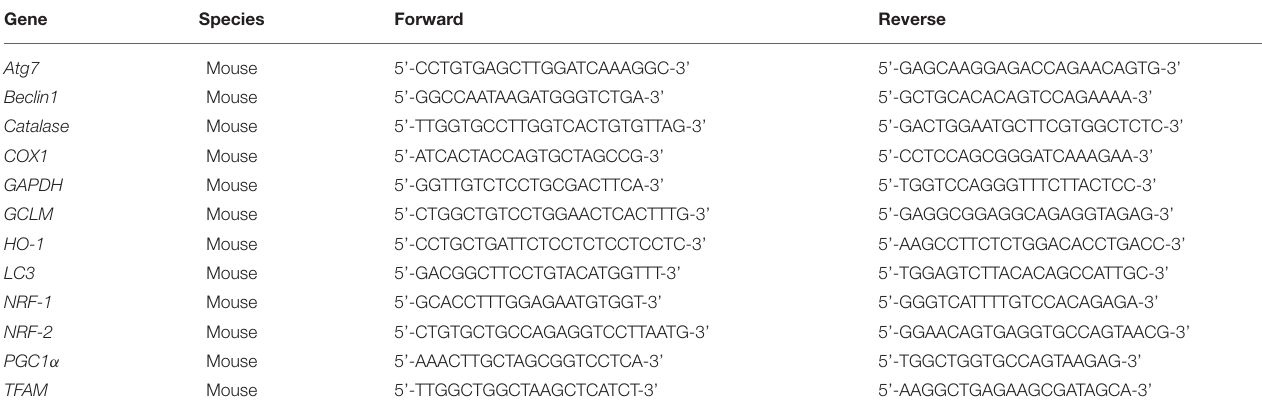
TABLE 1 | RT-qPCR primers. Gene Species